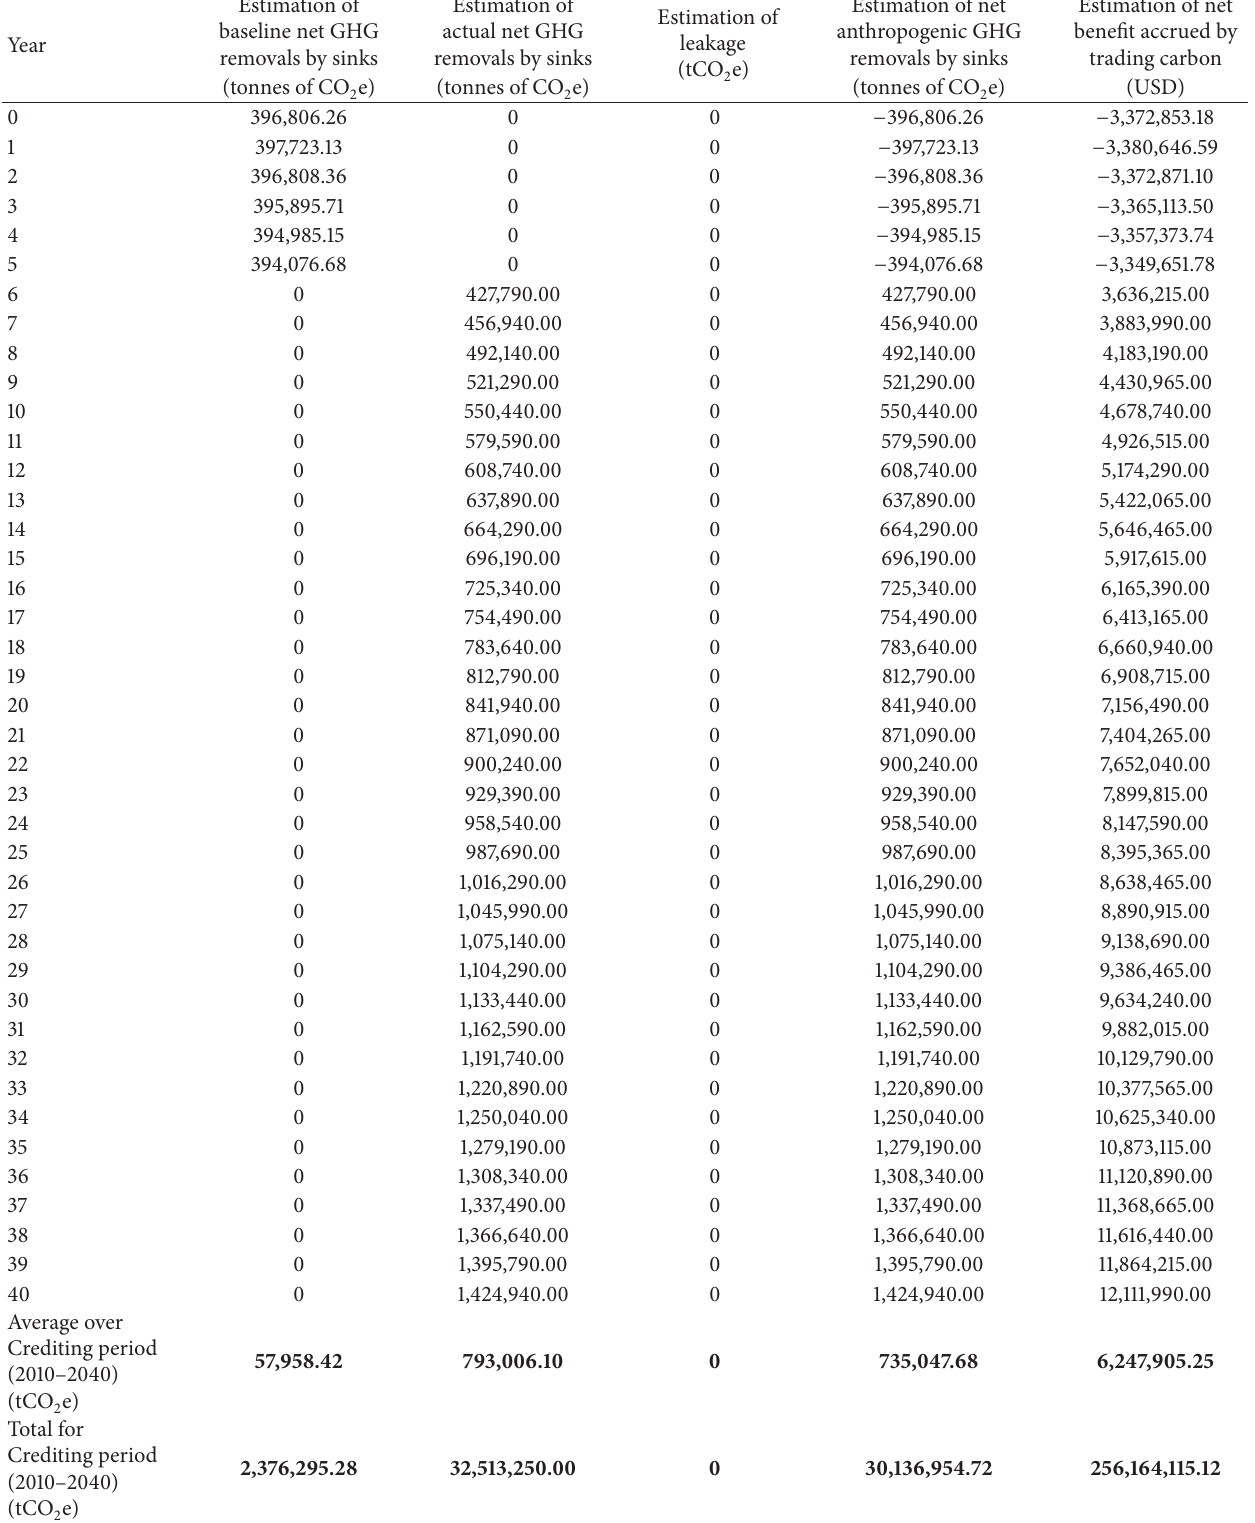
Table 4: Estimated amount of GHG abated